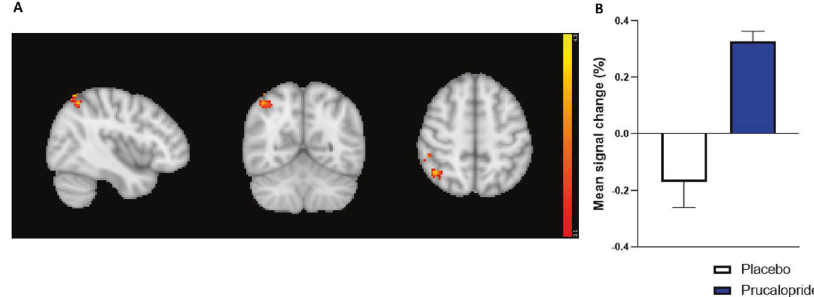
Fig. 4 Whole-brain activation in response to familiar mean in prucalopride vs. placebo group. A Sagittal, coronal, and axial images depicting signi fi cantly increased activation in the prucalopride group for the familiar mean contrast in a right angular gyrus cluster (peak voxel location x = 42, y = − 60, z = 60, Z = 4.1, cluster size = 168 voxels). Images thresholded at z > 3.1, p < 0.05 corrected. Red-to-yellow colours identify increases in brain activation. B Group mean of BOLD percentage signal change extracted from the right angular gyrus cluster (familiar mean). Error bars show standard error of the mean. White = placebo, blue = prucalopride. Table 2. Left and right hippocampal mean (SD) perfusion (ml/100